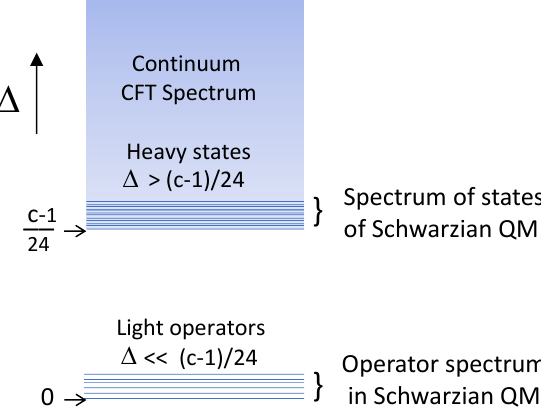
Figure 2 . The spectrum of states in the Schwarzian theory arises from the CFT spectrum of states with conformal dimension (cid:1) = c (cid:0) 1 + b 2 E , in the limit b 0. The operators in the Schwarzian are 24 ! all light CFT operators with conformal dimension (cid:1) = ‘